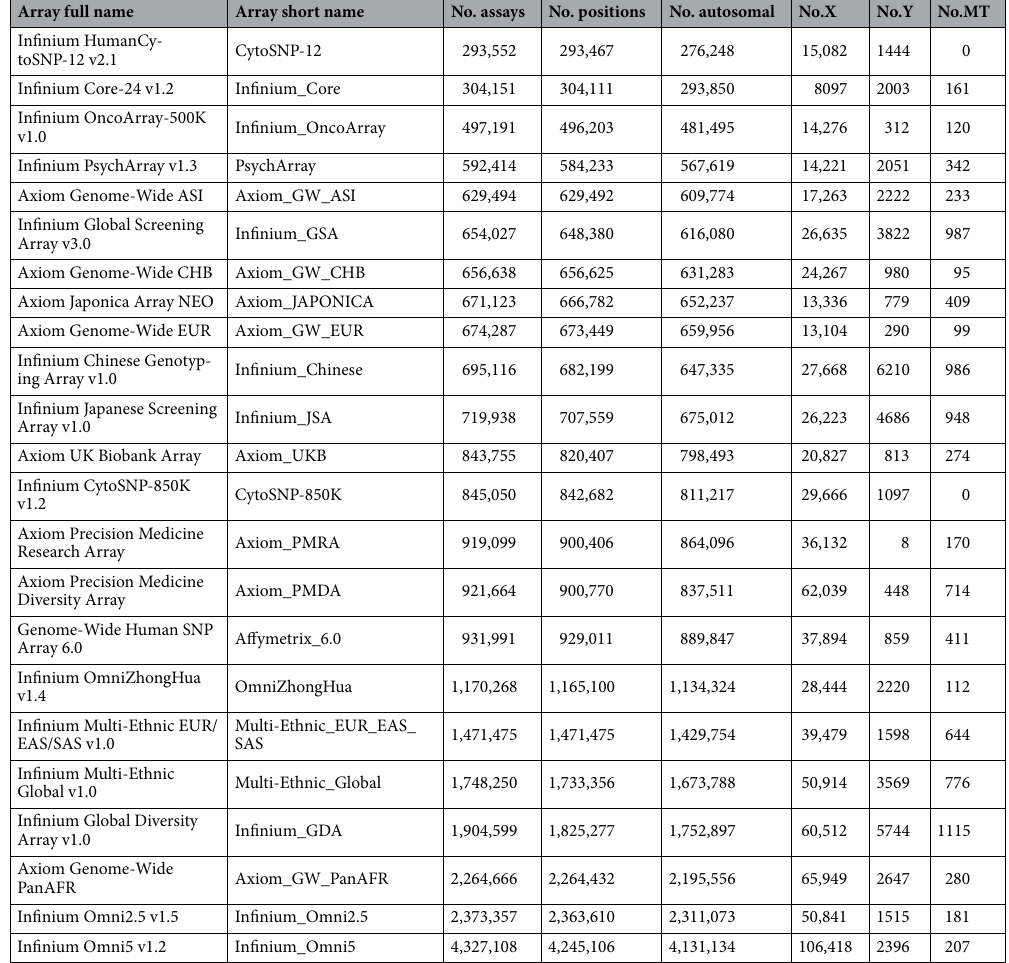
Table 1. Details of 23 human genotyping arrays used in this study. Short name of arrays are used interchangeablely with its full names throughout the texts, tables, and figures. No.Assays: number of assays included in the array; No.Positions: number of variants included in the array; No.Autosomal: number of variants of autosomal chromosomes included in the array; No.X, No.Y, and No.MT: number of variants of X, Y, MT chromosomes included in the array